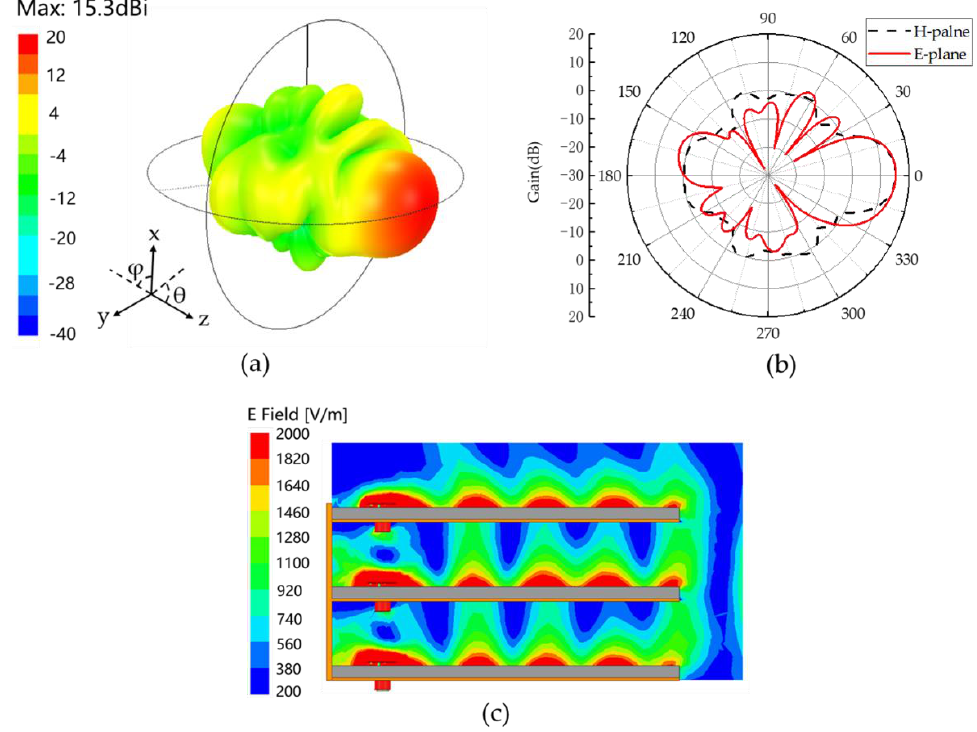
Figure 7. ( a ) Simulated 3D radiation pattern of the proposed array. ( b ) Simulated E-plane and H-plane radiation patterns of the proposed array. ( c ) E-field distribution in XOZ plane.